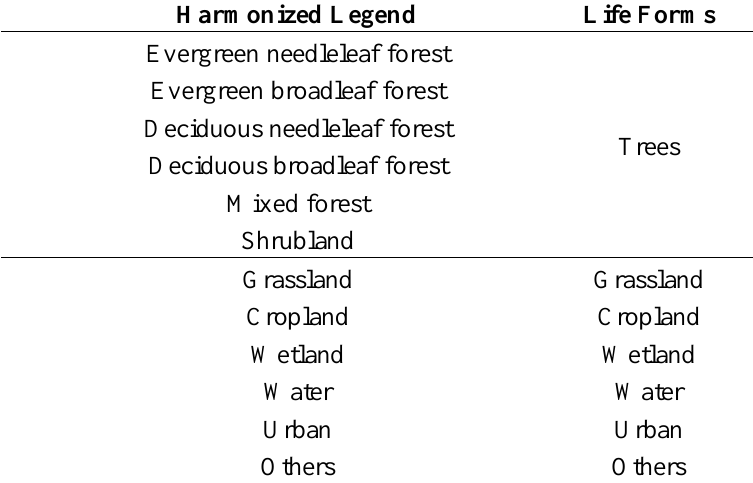
Table 1. Aggregation of land cover classes according to major life forms (refer to